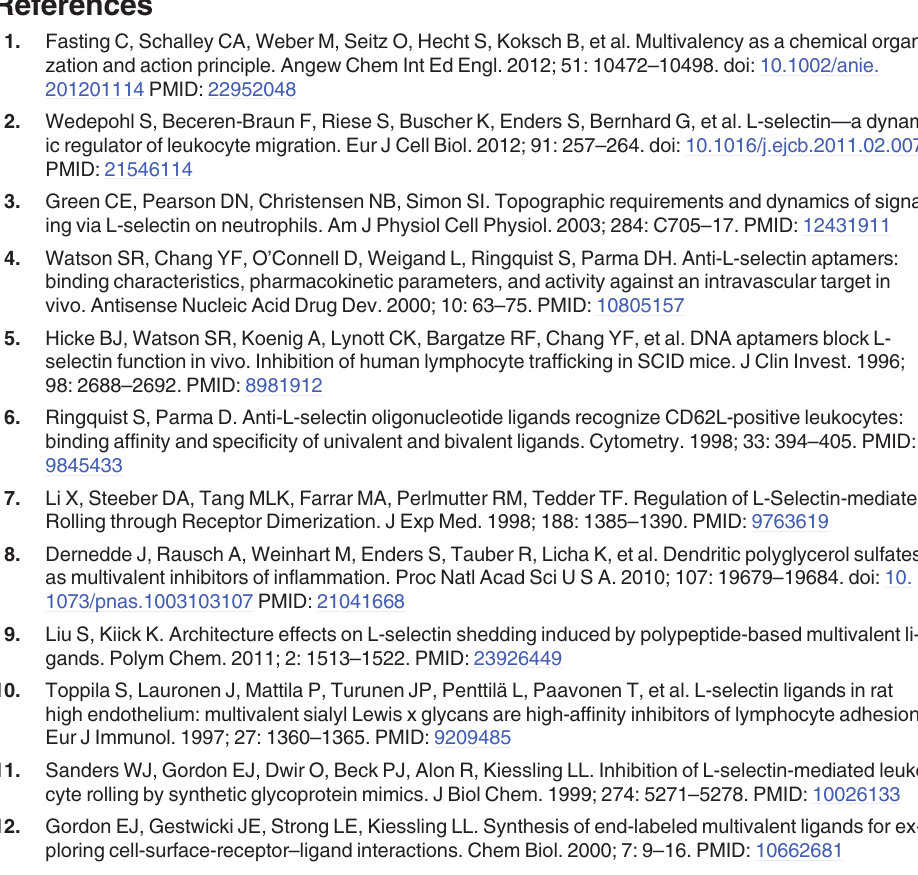
S1 Fig. Synthesis of FITC-labeled Multi-Aptamers. Following RCA reaction with 1:10 dilu- tion of FITC-dUTP to dNTP, the RCA products were analyzed via gel electrophoresis. The panel on the left is stained with Sybr Safe, while in the panel on the right the fluorescent RCA product can be visualized in the absence of Sybr Safe staining. (TIF) S2 Fig. LS-Multi-Aptamers interact with Jurkat cells. In this z-stack (planes indicated by yel- low lines), the RCA product can be observed almost entirely enveloping the Jurkat cell, which is labeled with Cell Tracker Red. Scale bar is 5 μ m.